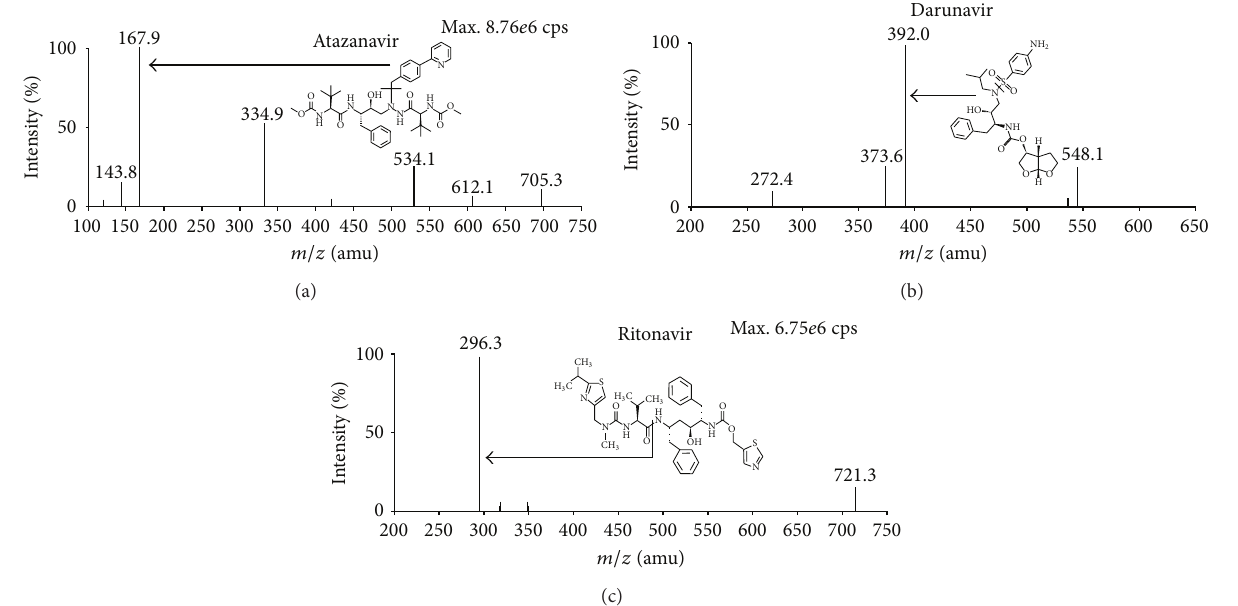
Figure 2: Product ion mass spectra of (a) atazanavir ( m/z 705.3 → 167.9, scan range 100–750 amu) (b) darunavir ( m/z 548.1 → 392.0, scan range 200–650 amu), and (c) ritonavir ( m/z 721.3 → 296.3, scan range 200–750 amu) in the positive ionization mode.